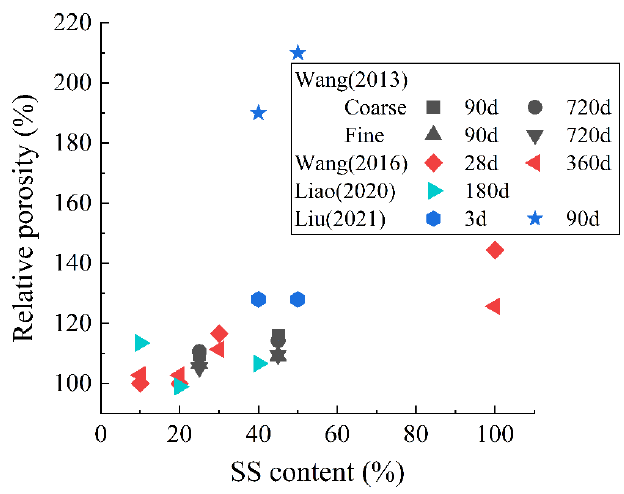
Figure 6. Relative porosity of hardened paste with SS as an SCM [12,13,102,104]. The relative porosity is the ratio of the porosity of composite paste containing metallurgical slag to that of the plain cement paste.